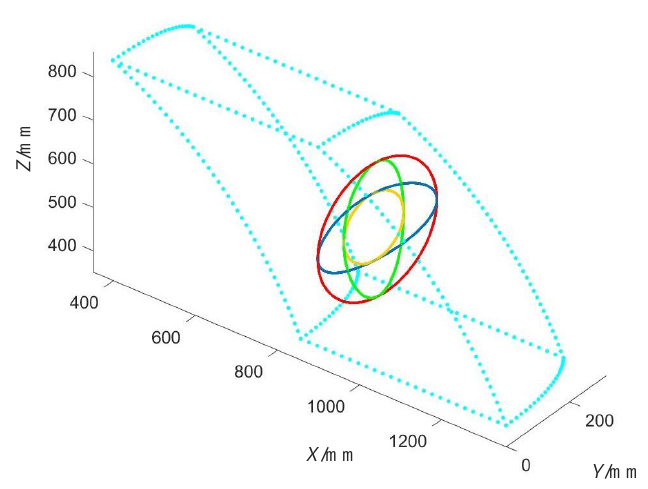
S 4 S 3 Figure 11. Circle training trajectory. where